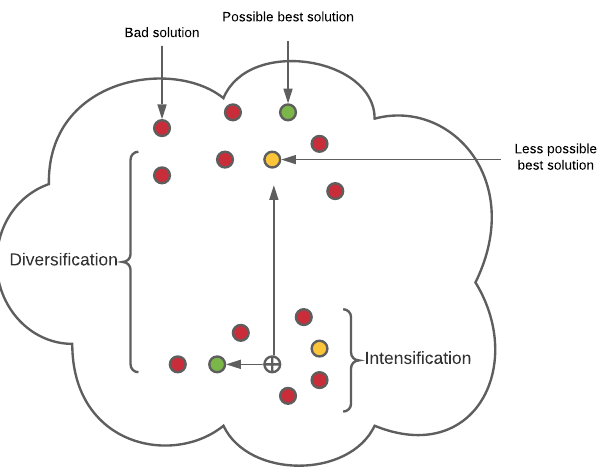
Figure 1. Graphic example of the search space illustrating green dots possible best solutions, yellow dots less possible best solutions, and red dots bad